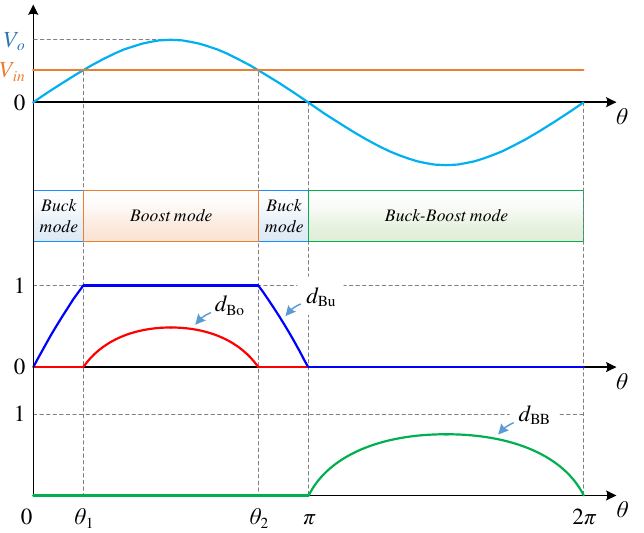
Figure 4. Variation of the duty cycles with the output voltage of the proposed single-stage Figure 4 . Variation of the duty cycles with the output voltage of the proposed single- stage BB-BTI.